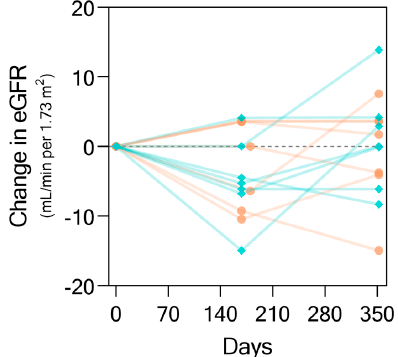
Figure 2. Changes in eGFR (by Modification of Diet in Renal Disease (MDRD) [16]) from baseline. Data shown here for the change in eGFR values over the time-course of the study for a subset of 14 patients who had complete urine samples collected at all three study time-points. Each line represents an individual patient trajectory. Trajectories in teal represent patients who received standard of care while those in salmon represent those who received Rituximab.